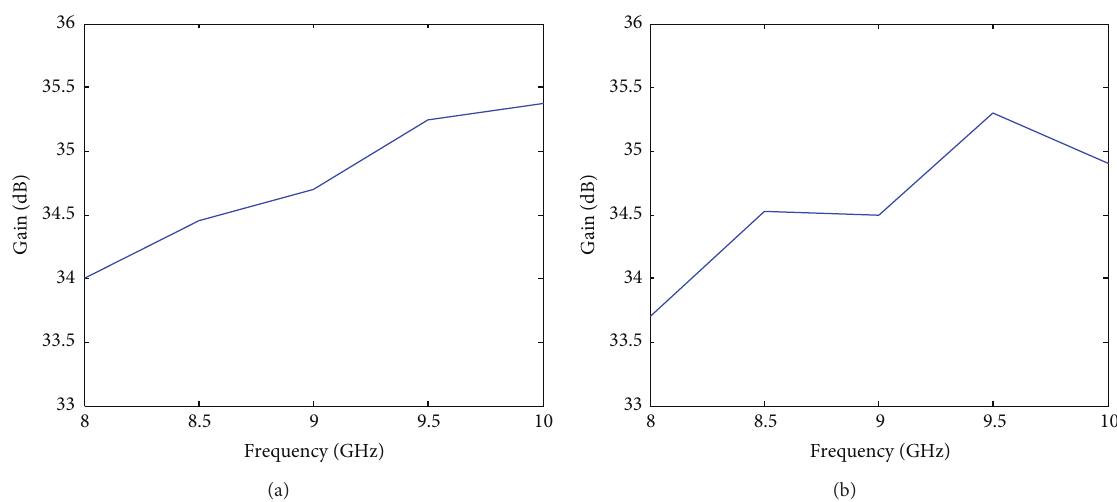
Figure 10: (a) Gain versus frequency of the simulated cassegrain antenna by FEKO. (b) The gain versus frequency of manufactured cassegrain antenna.